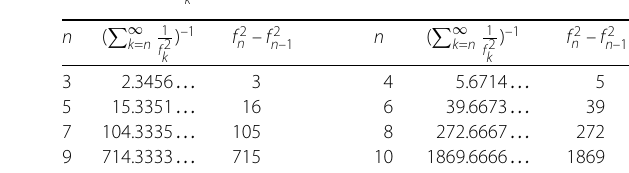
(cid:9) ∞ 1 ) k = n f 2 k